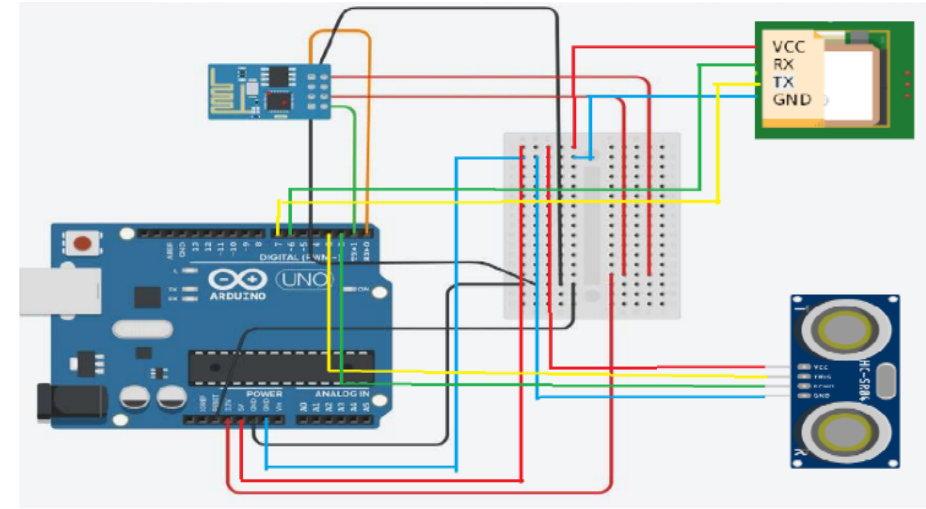
Figure 6. Schematic diagram for capacity monitoring.